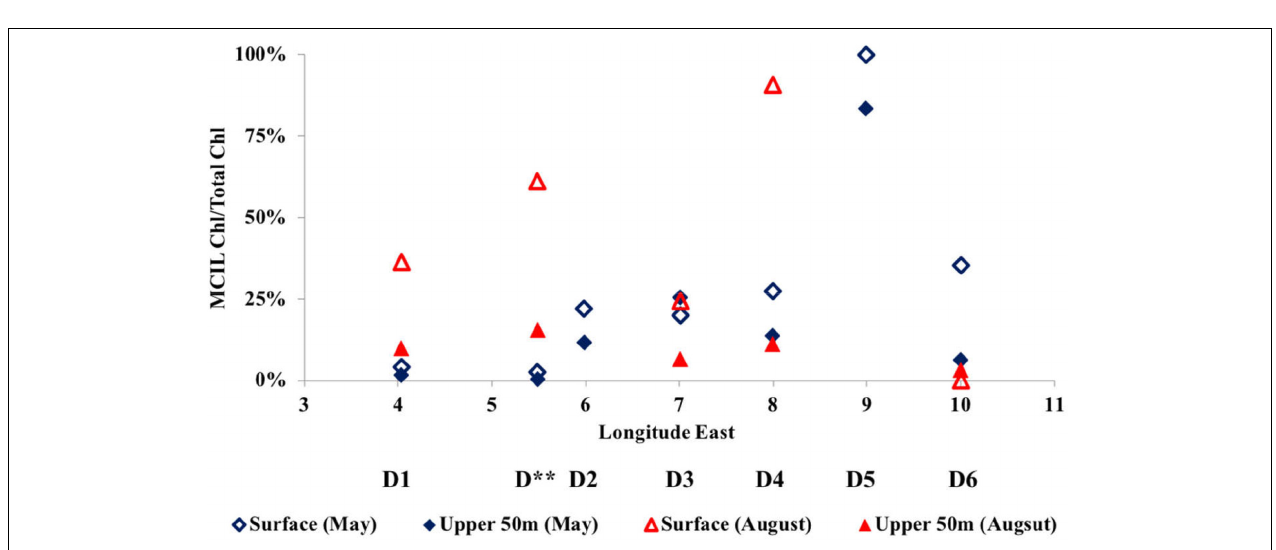
FIGURE 6 | The distribution of the mixotrophic ciliate chlorophyll to total chlorophyll ratio in the surface and the upper 50 m along the D transect in May and August 2014.